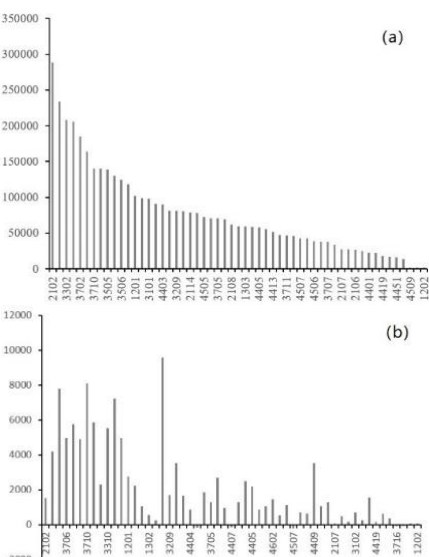
Figure 11. Statistics of coastal luminous areas at a city scale (a) radiation value (b) variation value